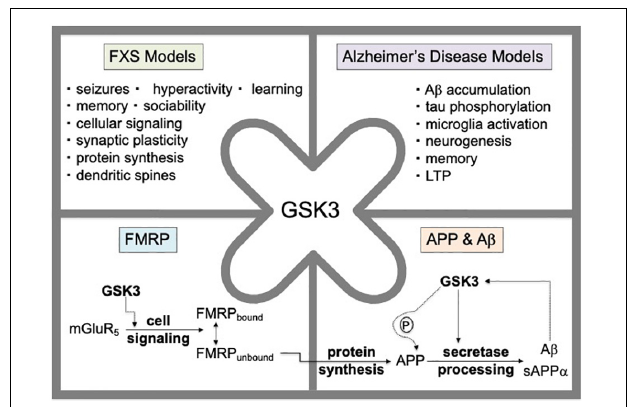
FIGURE 1 | GSK3 activation affects all major hallmarks of Alzheimer’s disease and FXS. GSK3 signals downstream of mGluR 5 and upstream of FMRP. The mGluR 5 /FMRP signaling pathway modulates the cellular protein synthesis of numerous FMRP target mRNAs including App mRNA. Genetic reduction of App by 50% in Fmr1 KO mice rescues behavioral, dendritic spine and electrophysiological phenotypes. GSK3 modulates APP and A β levels through phosphorylation of the carboxy-terminus of APP and via regulation of secretase enzymes involved in amyloidogenic processing of APP. The A β metabolite of APP can induce GSK3 activity suggesting a positive feedback regulatory